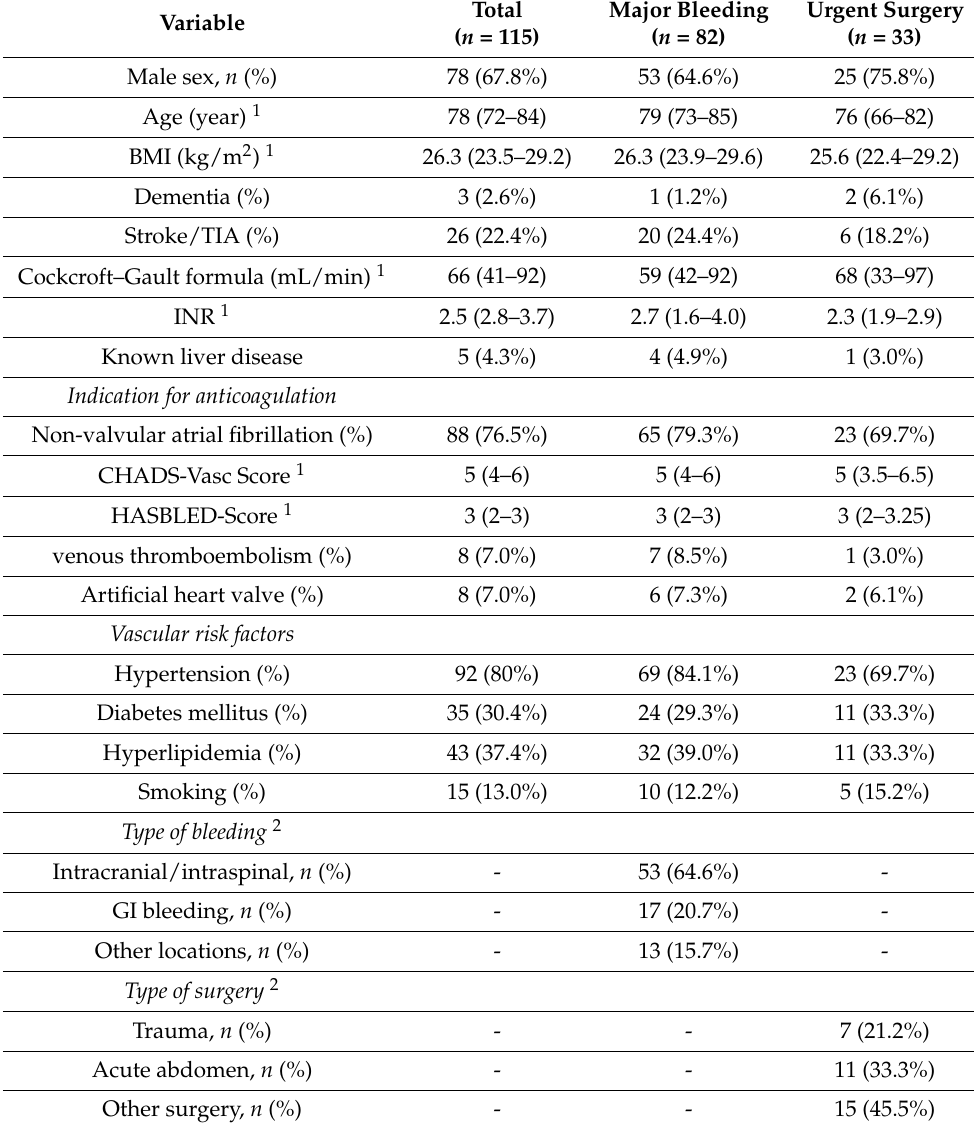
Table 1. Baseline characteristics of the patients